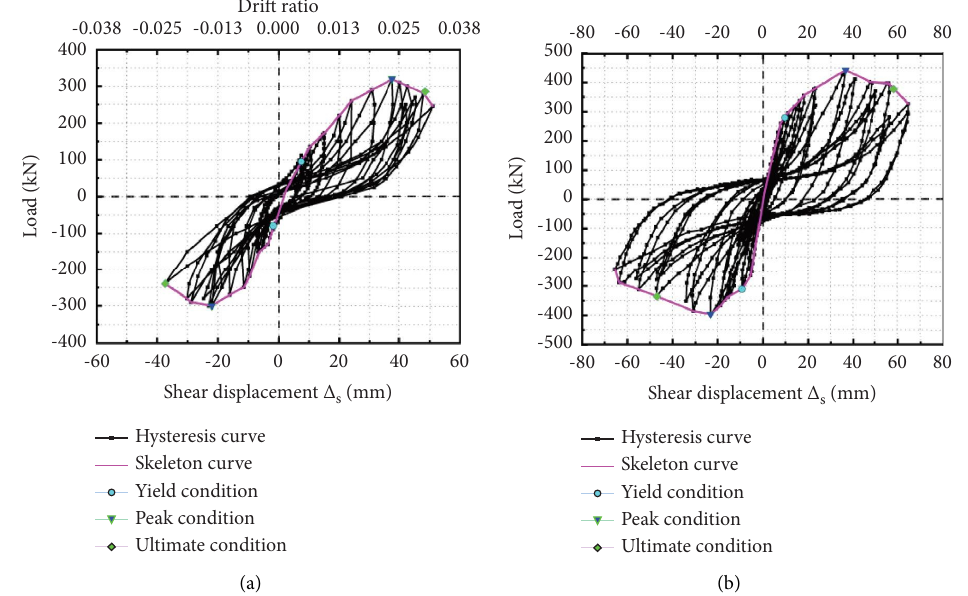
Figure 16: Hysteresis curve and skeleton curve. (a) URC-X. (b)